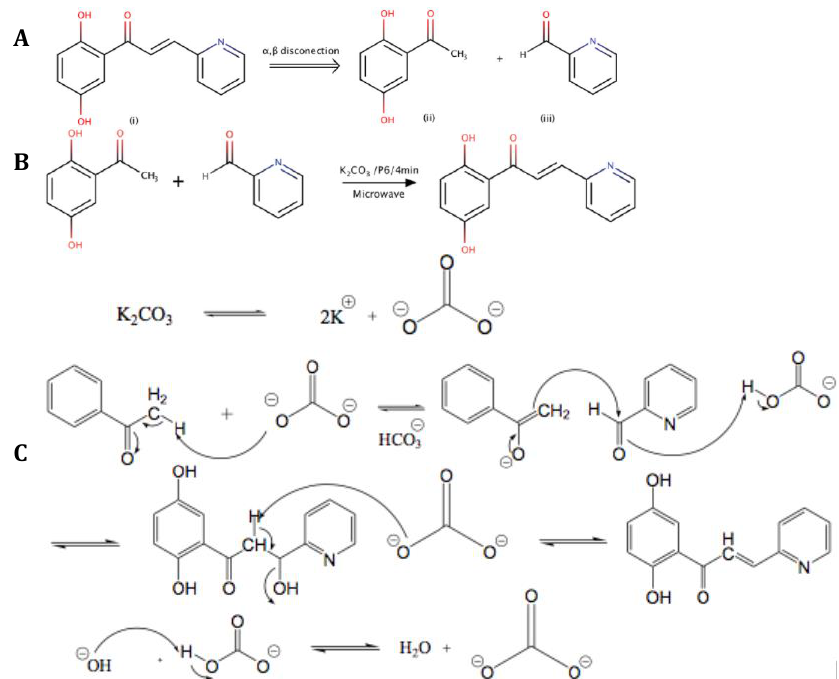
Figure 14. (A) Disconnection analysis of AEW-1 (i). AEW-1 was synthesized by reacting 2,5- dihydroxyacetophenone (ii) and pyridine-2-carbaldehyde (iii) by aldol condensation reaction. (B) Reaction of AEW-1. (C) Reaction mechanism of AEW-1. 2,5-dihydroxyacetophenone acts as a nucleophile while as pyridine-2-carbaldehyde is an